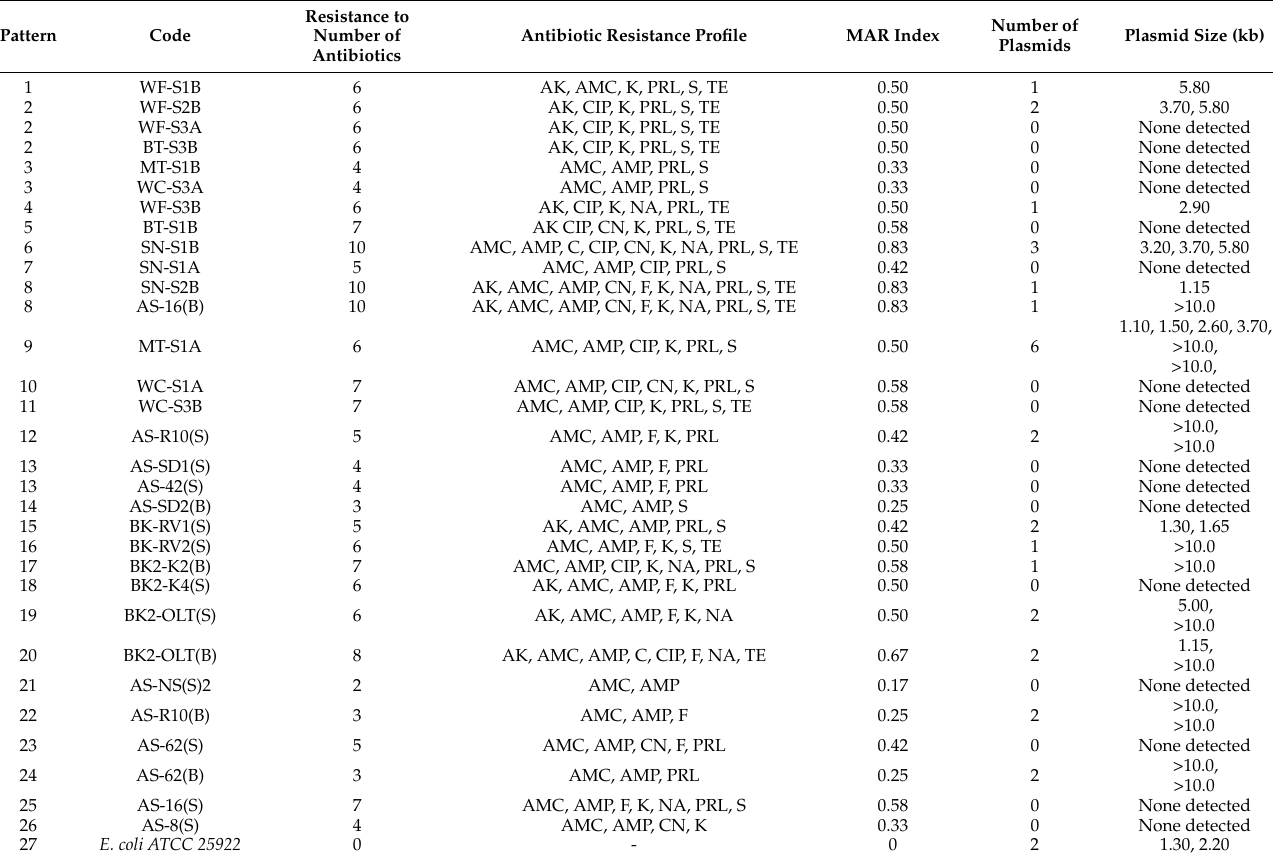
Table 3. Multiple-antibiotic-resistance (MAR) patterns and plasmid profiling of E. coli isolated from 6 Sarawak rivers and 3 aquaculture farms in Sarawak in northwestern